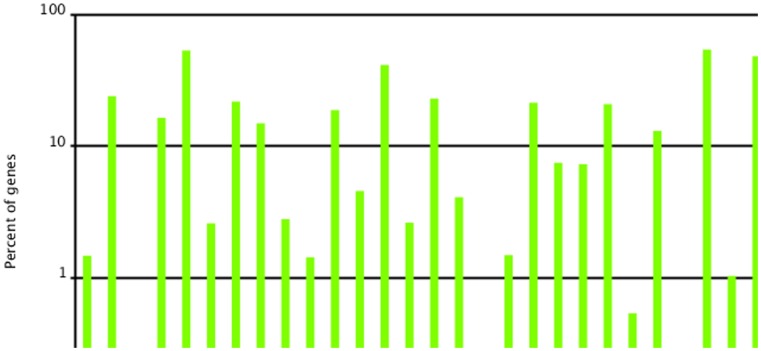
Classification of the gene ontology (GO) for the M. domestica transcriptome.7,063 unigenes (26.1% of total) were categorized into 48 function groups.